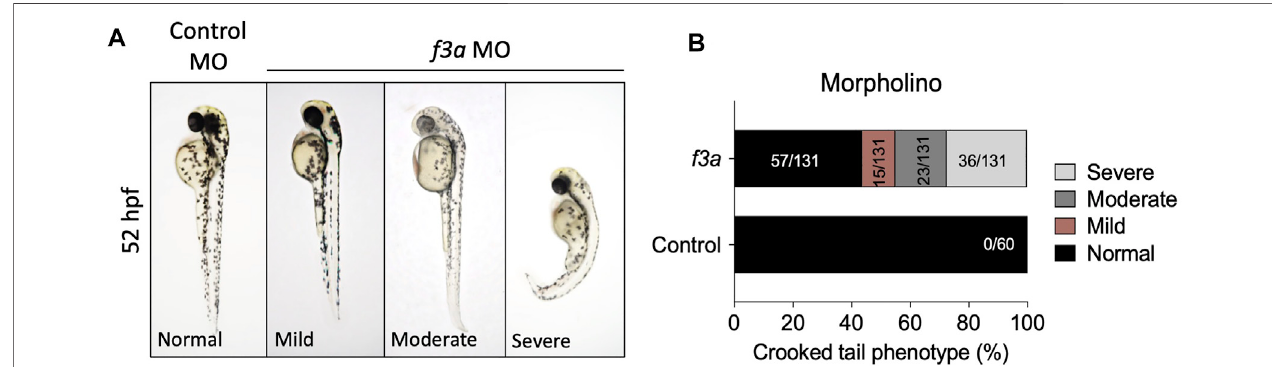
FIGURE 3 | MO-mediated knockdown of f3a expression results in morphological abnormalities: (A) Zebra fi sh embryos at 1-or 2-cell stage were injected with control and f3a MO and examined morphologically at 52 hpf. MO phenotypes: control MO injected (control MO), and mild, moderate, and severe phenotypes. (B) The morphological abnormalities were quanti fi ed. Numbers in the bars represent the ratios used to calculate the percentages. Data were pooled from three independent experiments.